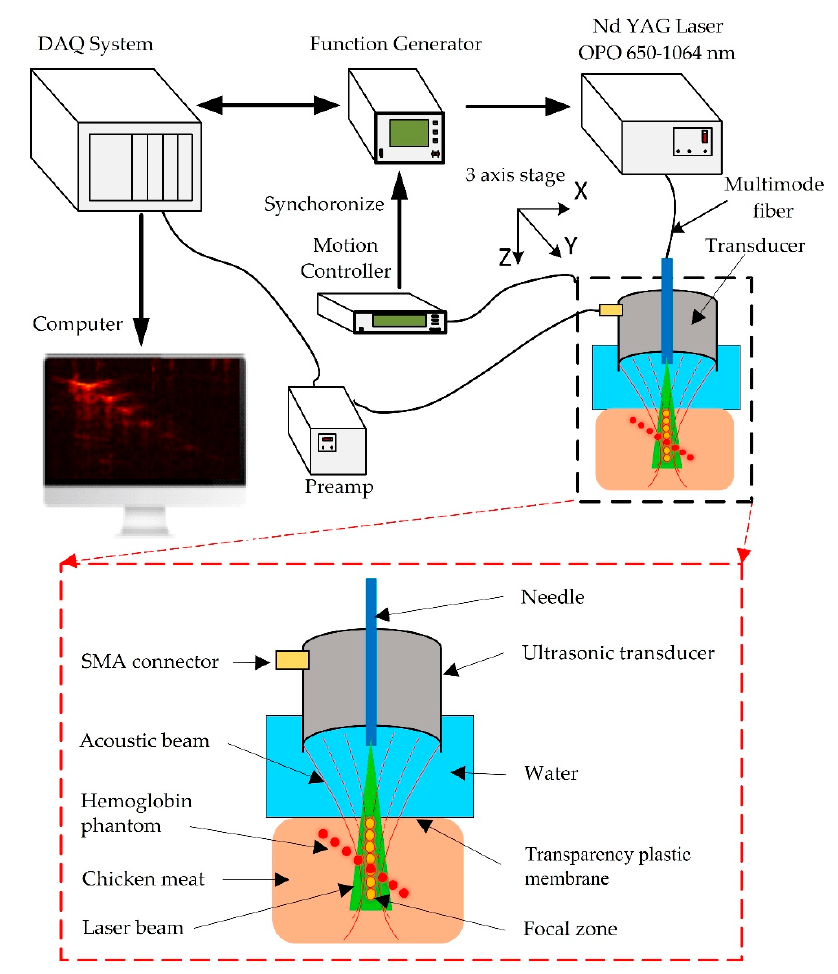
Figure 10. A schematic of the photoacoustic microscopy (PAM) experimental system. Laser OPO wavelengths: 650–1064 nm. Multimode fiber diameter: 1 mm, NA = 0.5.